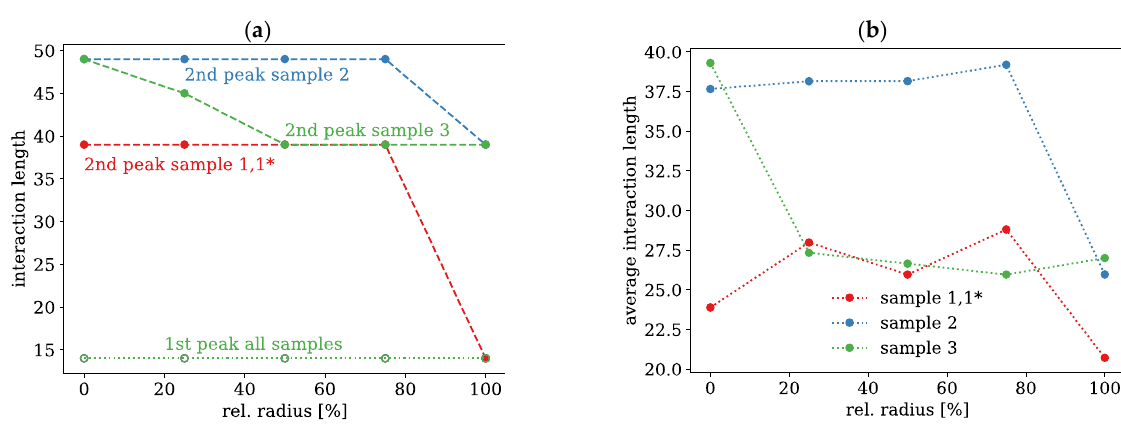
Figure 10. Location of the two maxima in the histograms ( a ) and simulated evolution of average interaction lengths over the radius of the investigated fibre samples ( b ).